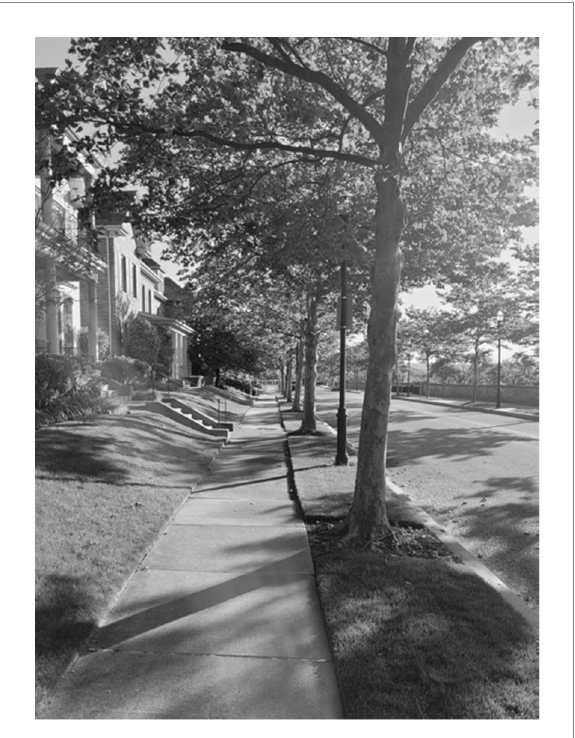
FIGURE 1 One of several repeatedly observed streets in the Summerset neighborhood of Pittsburgh,